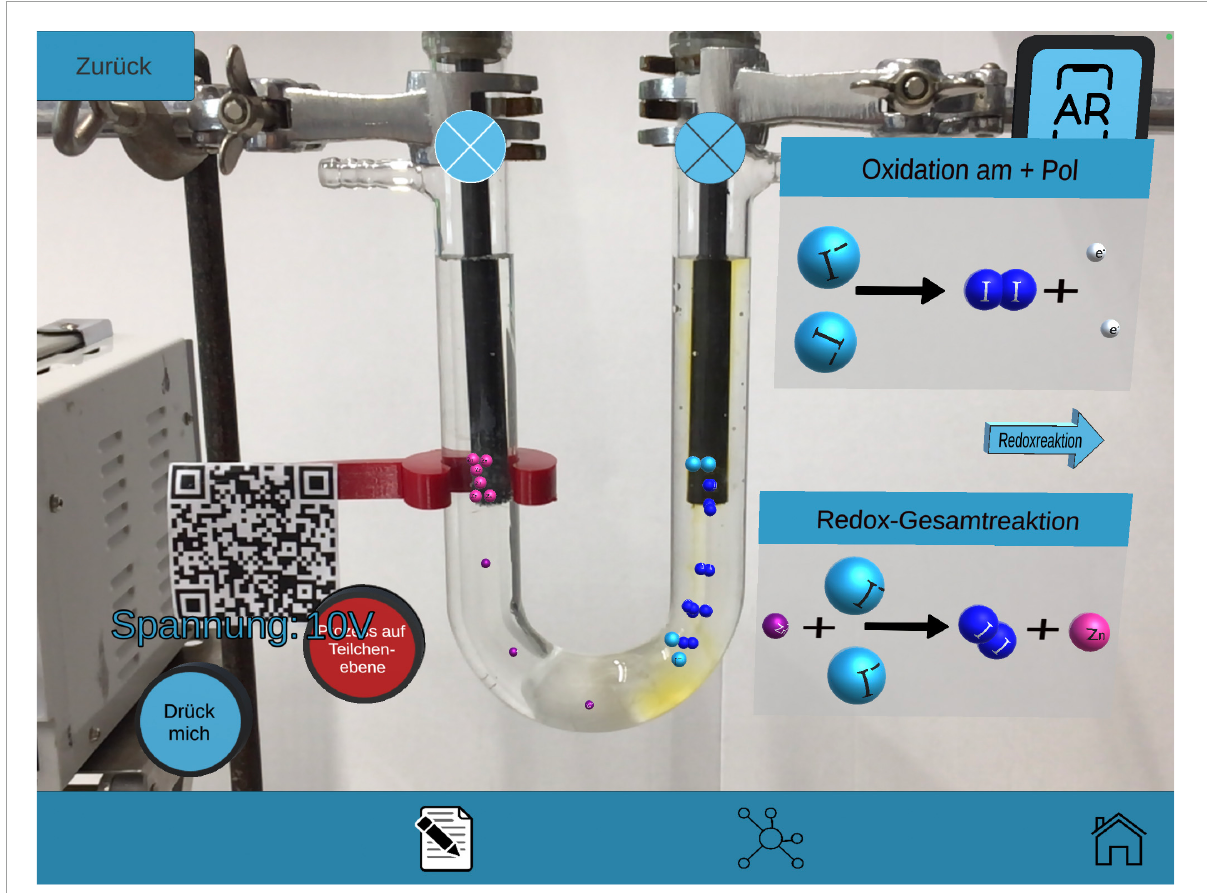
FIGURE1 View through a tablet on the real experiment with virtual overlays of the learning path chemical reaction : Pictorial representation after clicking the buttons “Oxidation” and “Redox reaction” with the particle level processes (after switching on the DC voltage